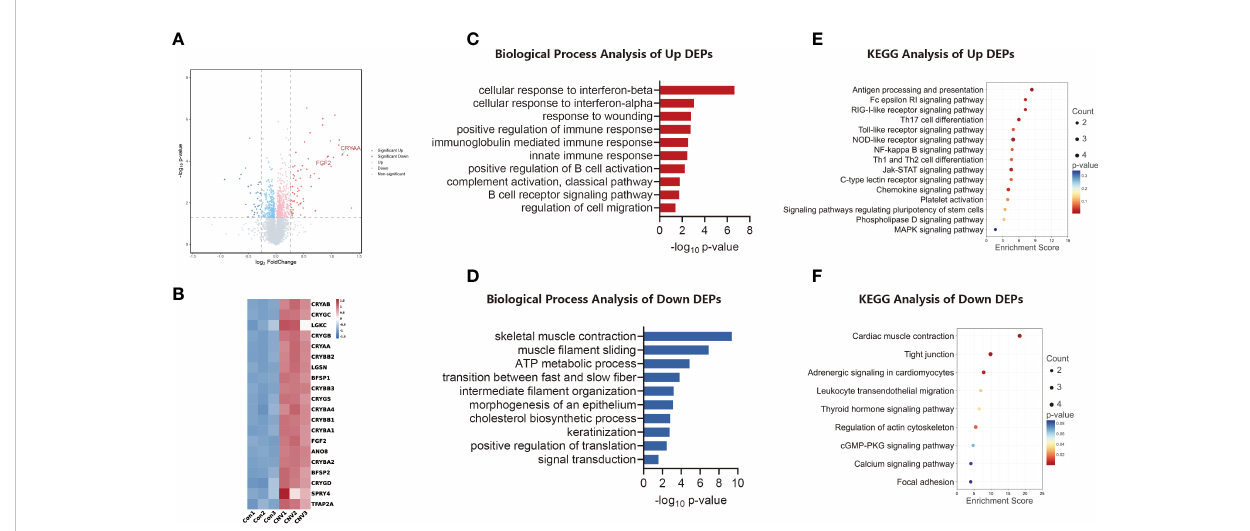
FIGURE 2 Proteomic analysis of CNV mouse retina. (A) Volcano plot visualizing proteomic alterations, where red dots represent proteins upregulated in the CNV group (compared to the control group; 73 proteins), blue dots represent proteins downregulated in the CNV group (31 proteins). (B) Heatmap of the top 20 differentially expressed proteins (DEPs) between CNV and control retinas. (C) Bar chart of sectional biology progress (BP) gene ontology (GO) terms of upregulated DEPs. (D) Bar chart of sectional biology progress (BP) gene ontology (GO) terms of downregulated DEPs. (E) Bubble plot of partial enriched Kyoto Encyclopedia of Genes and Genomes (KEGG) pathway terms of upregulated DEPs. (F) Bubble plot of partial enriched KEGG pathway terms of downregulated DEPs.